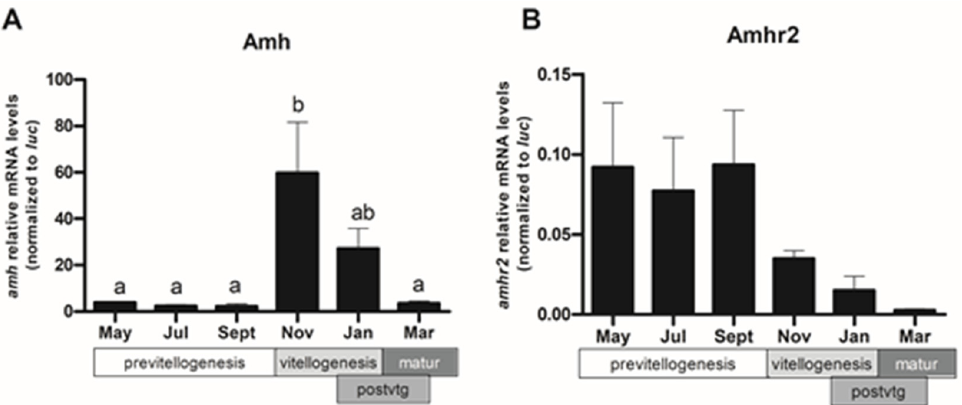
Figure 6. Relative expression of amh ( A ) and amhr2 ( B ) in sea bass ovarian follicular cells during the reproductive cycle. Values represent the mean ± SEM ( n = 3–4 fish/month) of each month and were analyzed by ANOVA followed by Tukey’s significant interaction test. Different significance levels ( p < 0.05) are indicated with different letters above the bars, except for amhr2 ( p = 0.1824).